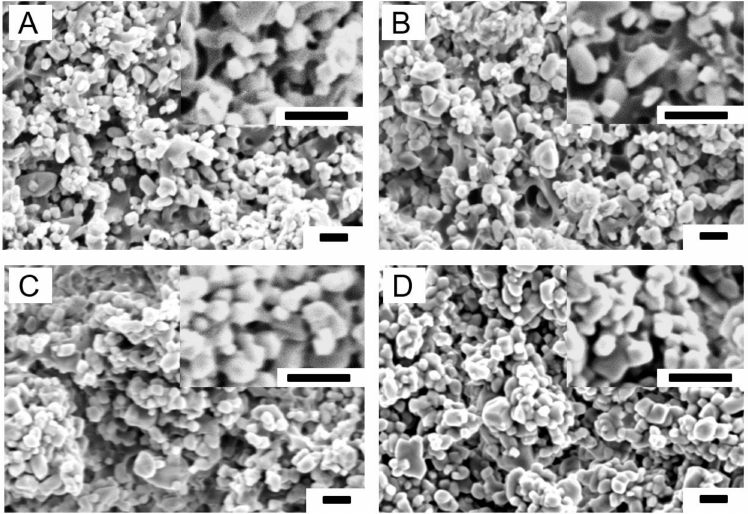
Figure 2. SEM pictures of cross-sections of PTMC / CaCO 3 composite films. ( A ) PTMC / 30; ( B ) PTMC / 40; ( C ) PTMC / 50; ( D ) PTMC / 60. Scale bars 1 µ